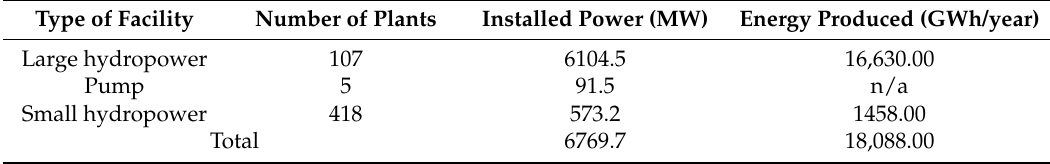
Table 4. Hydropower facilities in operation, 2016.